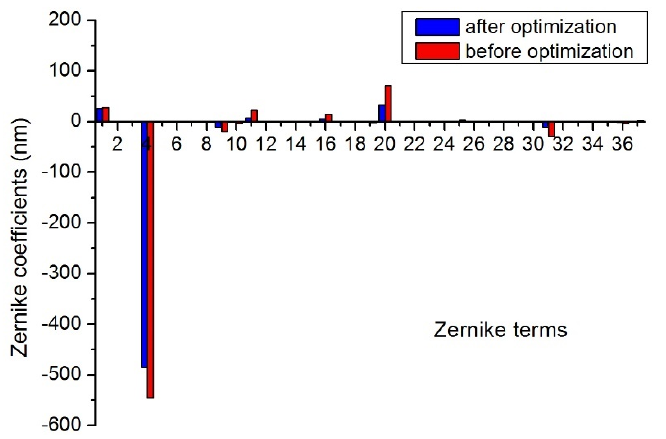
Figure 5. Zernike coefficients under 30 °C uniform temperature decrease before and after the optimization.